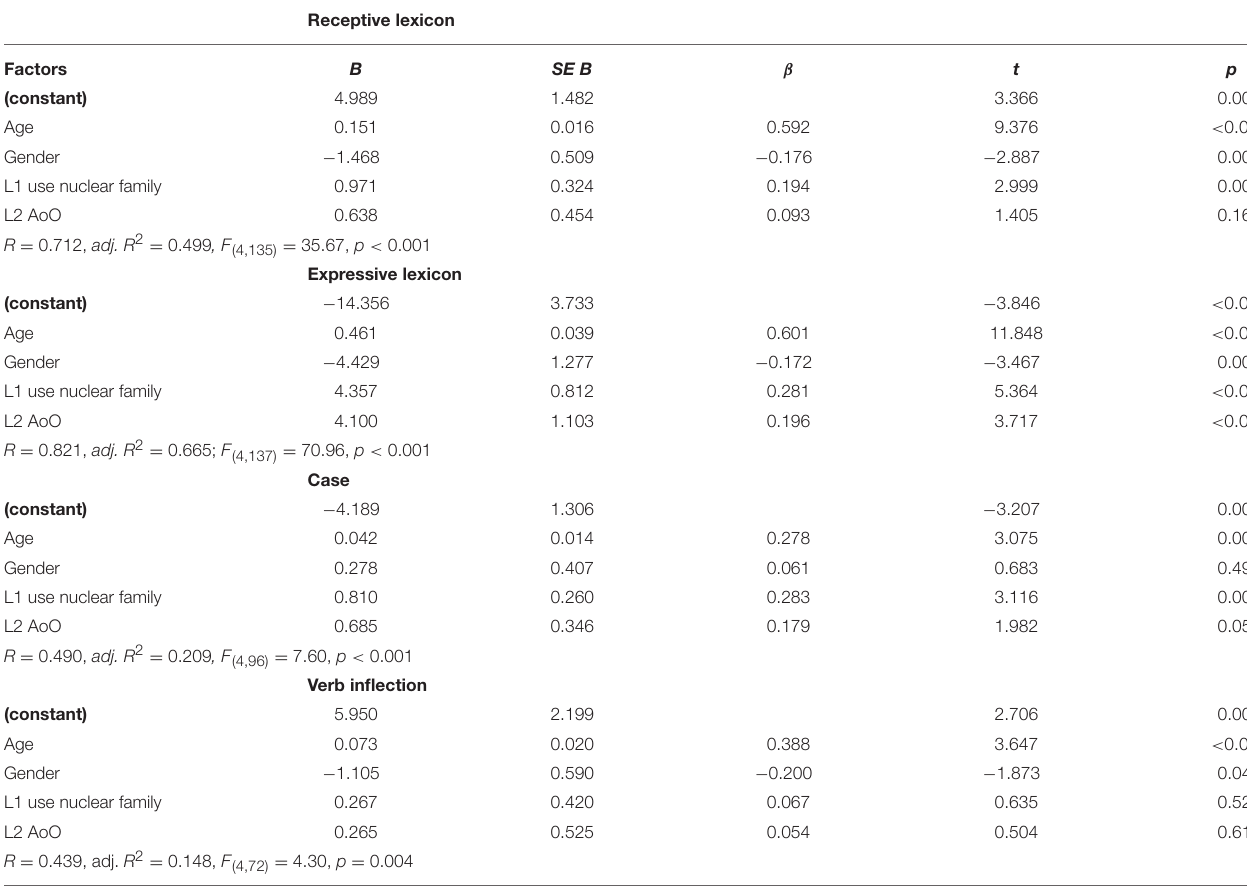
TABLE 4 | Multiple regression models for each language competence